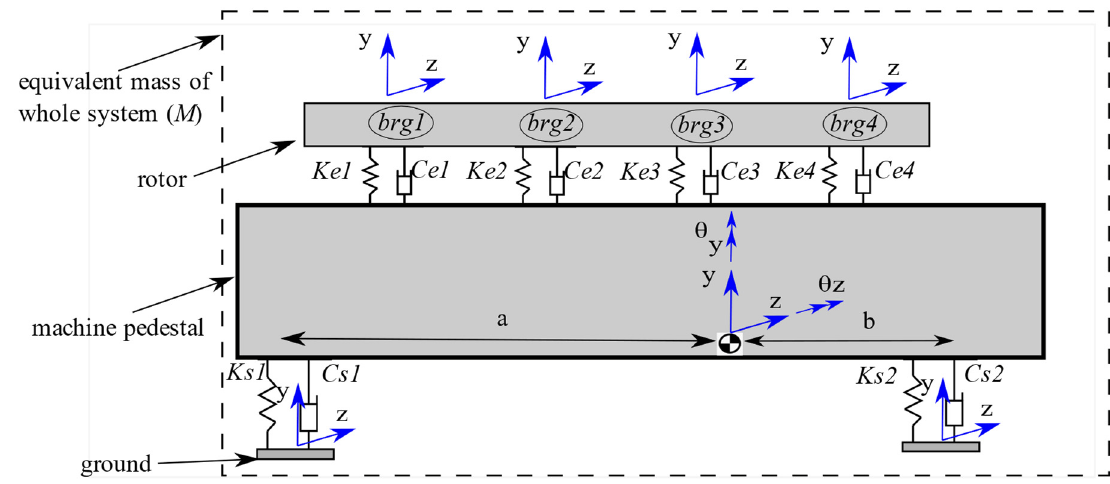
Figure 9. Equivalent model of the setup for support stiffness identification.